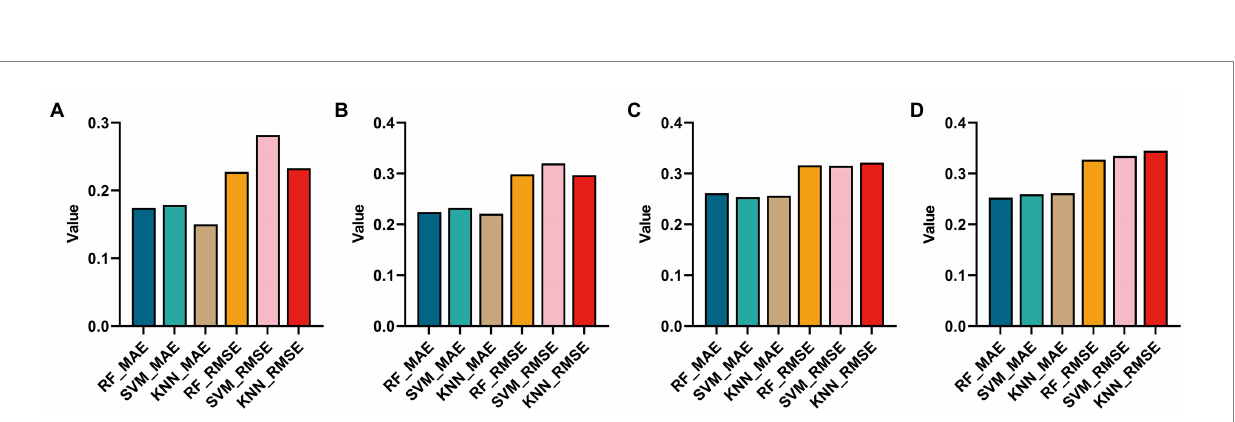
FIGURE 9 Histograms obtained by using three regression methods (RF, SVM and KNN) to regress MMSE and using two regression evaluation indicators (MAE and MSE). (A,B) Are the regression results using the Top ROIs and genes of the AD group, respectively. (C,D) Are the regression results of Top ROIs genes using the MCI group,